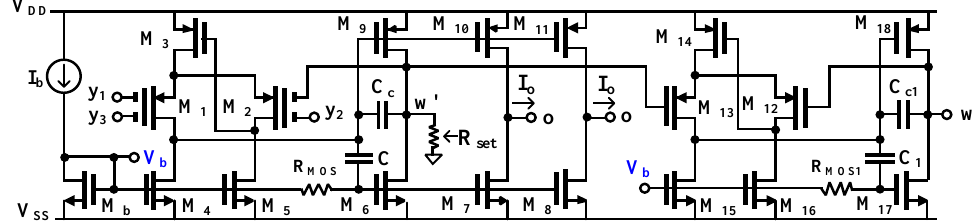
Figure 2. TA-based DDA using MI-MOSTs.